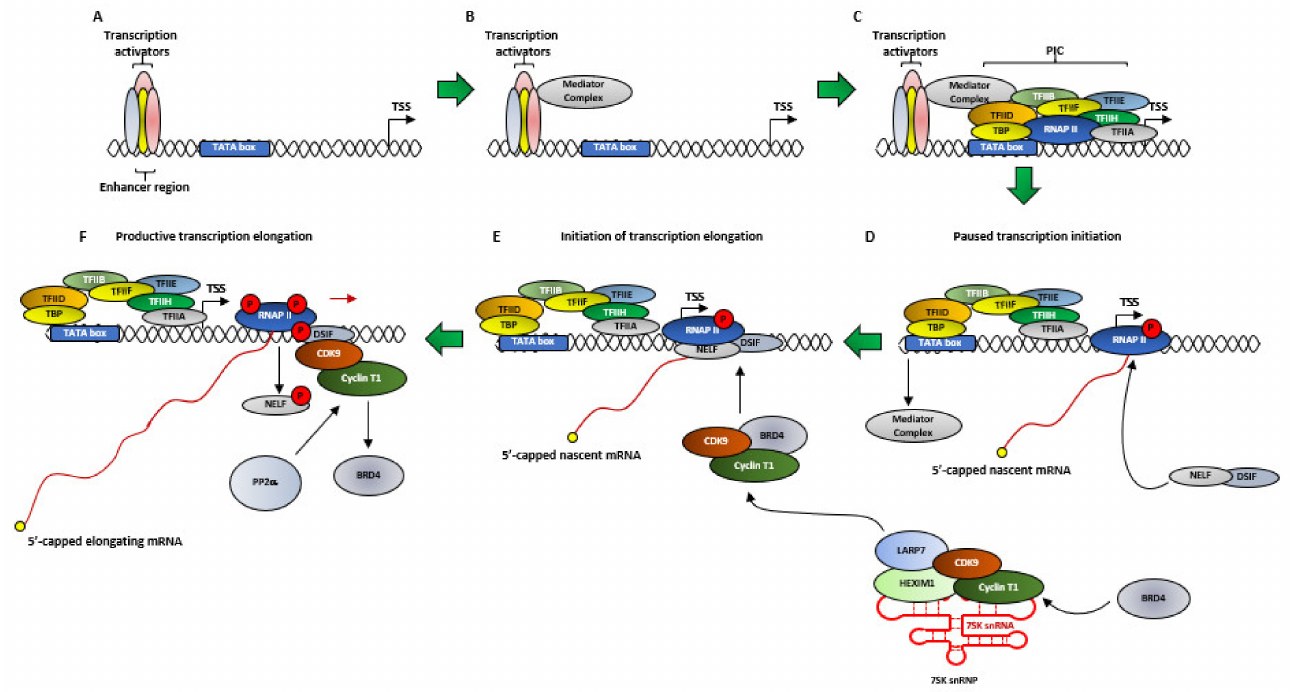
Figure 4. The simplified model of the regulation of transcription by P-TEFb. ( A ) At the beginning of transcription, Transcription Factors (TFs) bind to the enhancer regions, upstream of the core promoter region (represented by the TATA box). The TATA box in-turn is located upstream of the Transcription Start Site (TSS). ( B ) TFs recruit the Mediator Complex (MC) (Simplified here from Figure 3). ( C ) The MC then assists in the recruitment and assembly of the PIC on the DNA strand which, as mentioned before, starts promoter melting and form the transcription bubble, to allow to the RNAP II to access the DNA template strand. ( D ) The TFIIH subunit of PIC also phosphorylates the S5 residue at the CTD of RNAP II to initiate transcription from the TSS to generate a nascent mRNA transcript of ~50 ribonucleotides but pauses due to recruitment of two negative regulators of transcription DSIF and NELF. The S5 phosphorylation also enables the dissociation of the MC and freeing-up of the RNAP II from the PIC and promotes the recruitment of capping enzymes to cap the 5 (cid:48) -end of the nascent mRNA strand in a multi-step process, to prevent the nascent strand from being degraded by nucleases like XRN2. The cap remains until transcription finishes and the mRNA is properly processed. ( E ) When it is ideal for the cells to carry-out productive transcription, BRD4 recruits P-TEFb (CDK9/Cyclin T1) from its negative regulatory complex—7SK snRNP to the RNAP II. However, the kinase activity of the BRD4 bound CDK9 remains transiently inhibited due to the phosphorylation of T29 of CDK9 by BRD4 ( F ) The phosphatase PP2 α is then recruited which dephosphorylates T29, restoring the kinase activity of CDK9. This causes the additional P-TEFb mediated phosphorylations of RNAP II at S2, the SPT5 subunit of DSIF at T4 and NELF. This allows NELF to dissociate from RNAP II, which along with SPT5 phosphorylation, transforms DSIF to a positive elongation factor. These events relieve RNAP II from transcription pause and allows it to progress along with the DNA template to initiate productive transcriptional elongation. As the transcription elongation gears-up, BRD4 was released from the